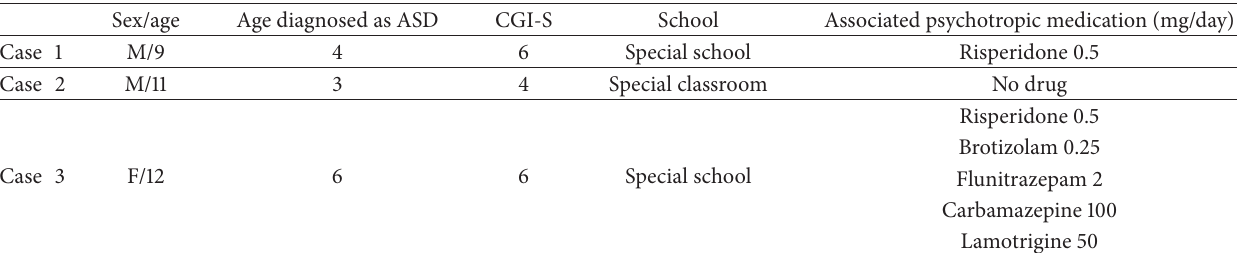
Table 1: Patient background.